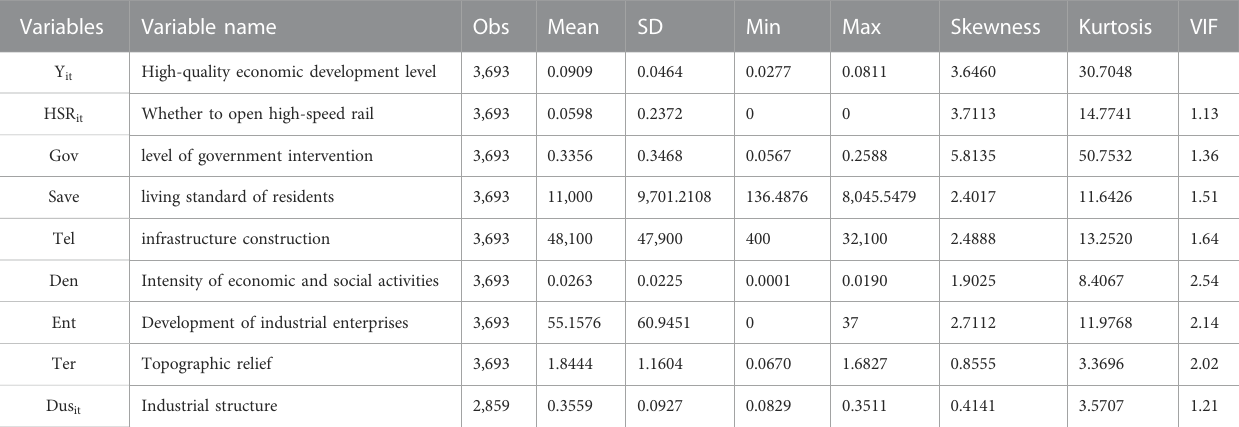
TABLE 3 Descriptive statistics of main